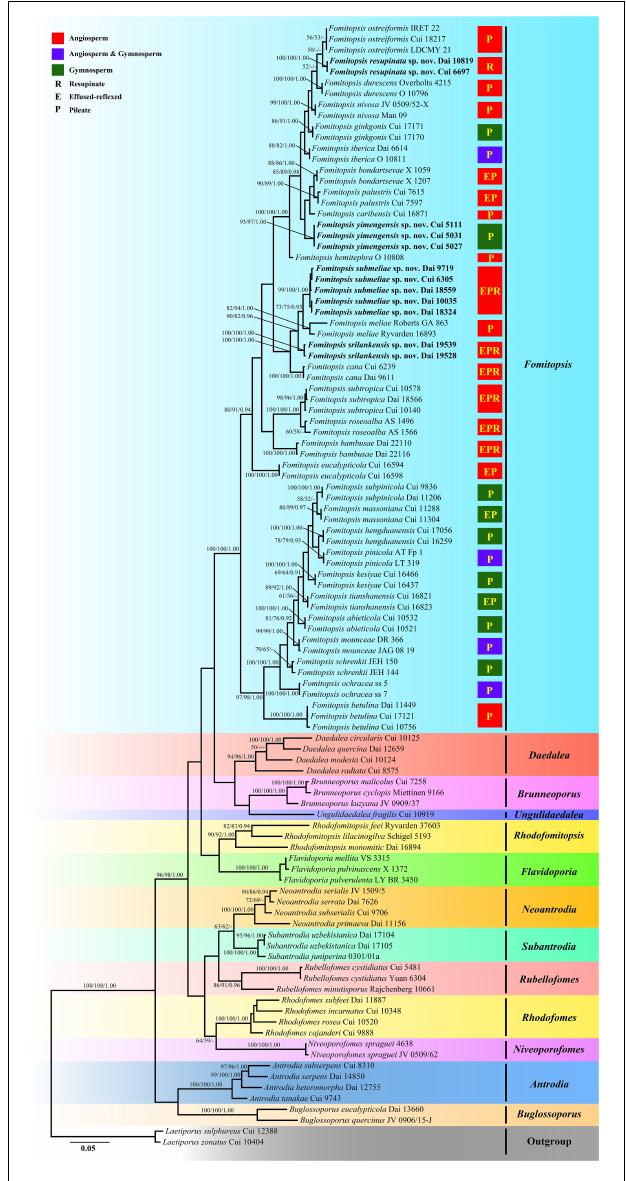
FIGURE 1 | Maximum likelihood tree illustrating the phylogeny of Fomitopsis and its related genera in the antrodia clade based on the combined sequences dataset of ITS + nLSU + nSSU + mtSSU + RPB2 + TEF. Branches are labeled with maximum likelihood bootstrap higher than 50%, parsimony bootstrap proportions higher than 50% and Bayesian posterior probabilities more than 0.90, respectively. Bold names = New